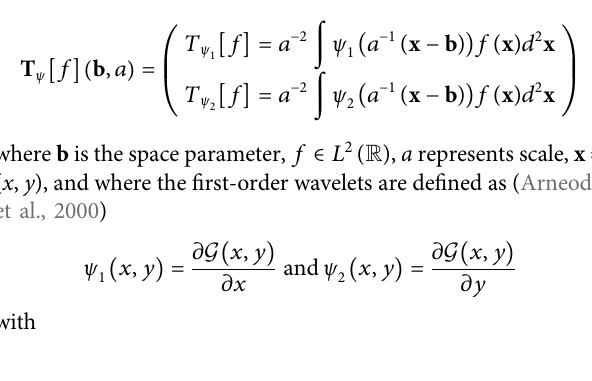
Frontiers in Physiology |